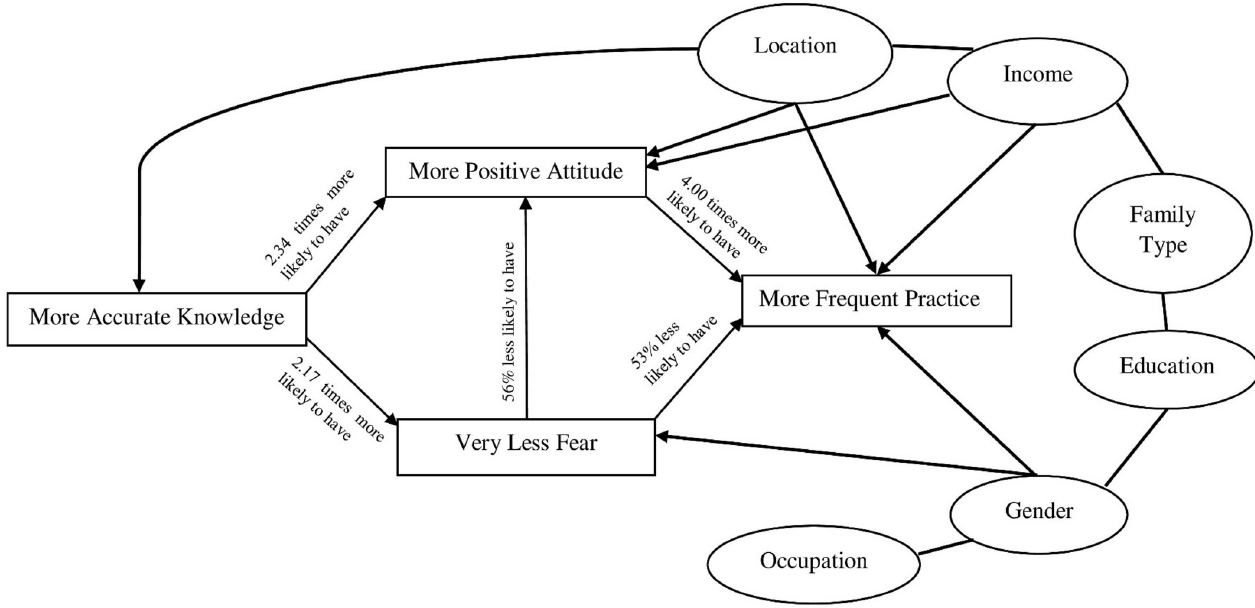
Fig 3. Diagram showing the direct and indirect impact of knowledge, attitude, fear, and socio-demographic factors (Ellipse) on preventive